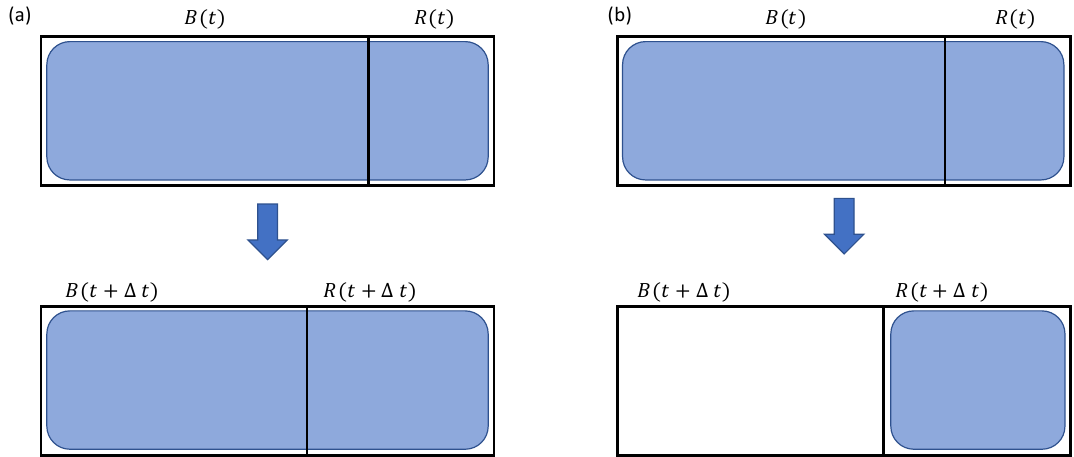
Figure 3 . Evolution of the operator gas in an evaporating black hole. In all cases, the region on the left represents the black hole, and the region on the right represents the radiation. The black hole subsystem B ( t ) grows smaller as a function of time during the evaporation process, while the radiation subsystem R ( t ) grows larger. (a) During evolution, an operator which is supported in the full system (i.e. including both B and R ) remains supported in both subsystems. (b) Operators which are initially supported in the black hole at time t have some probability of “jumping” outside B ( t + ∆ t ) at a later time, forming a void which includes the black